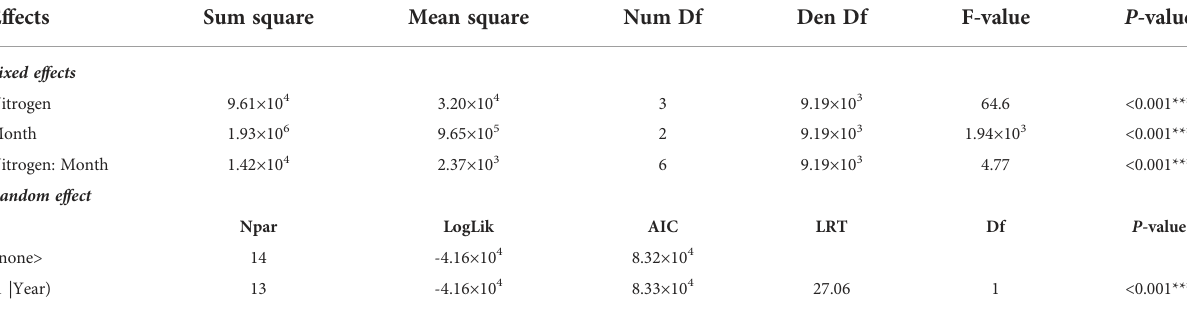
TABLE 1 Linear mixed-effects model predicting in fl uences of nitrogen, month (including May, July, and September) on the plant height of the common reed.